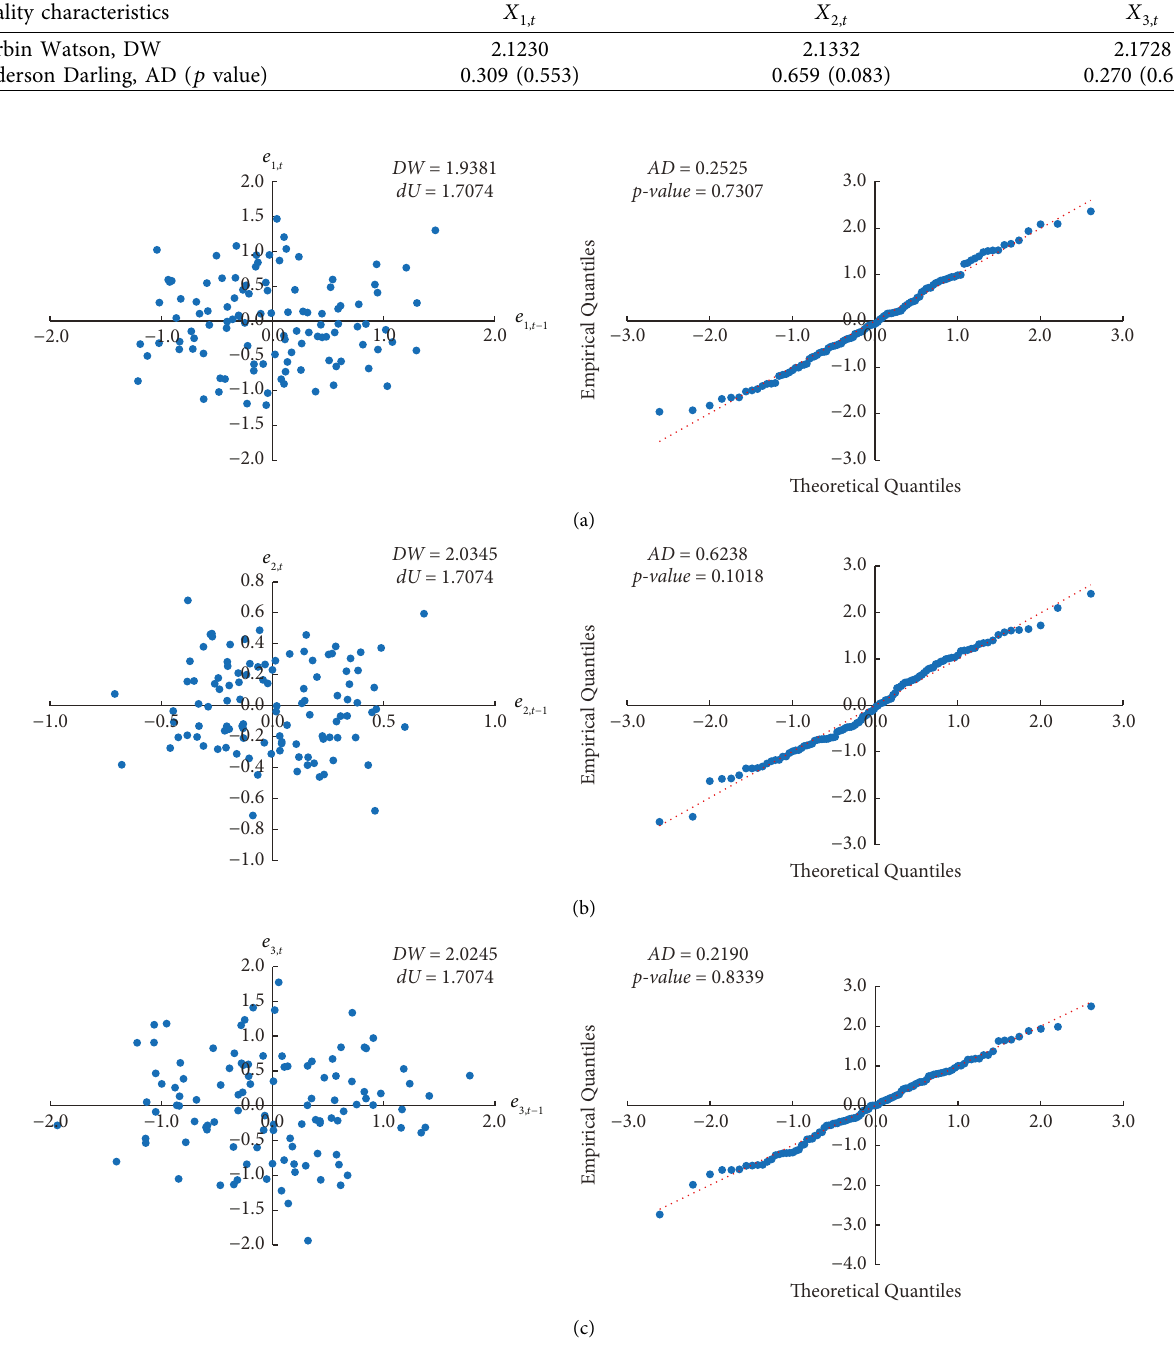
, X , and X . 1 ,t 2 ,t 3 ,t